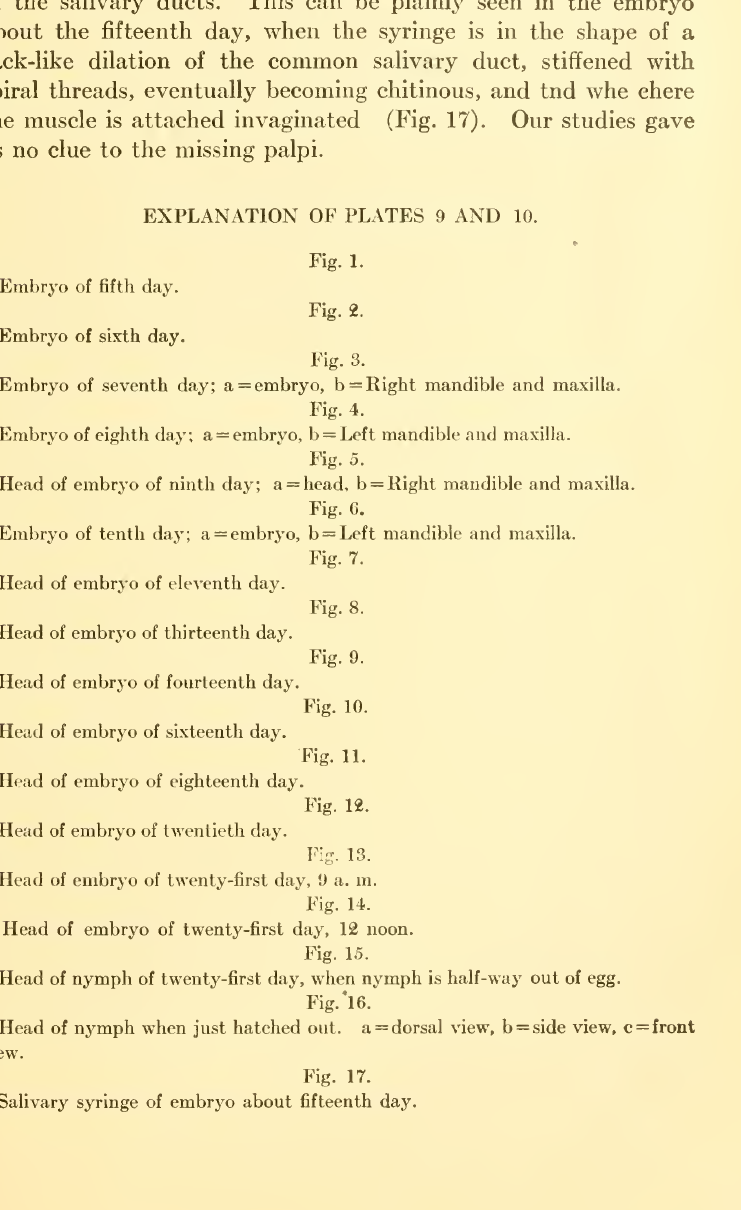
Salivary syringe of embryo about fifteenth